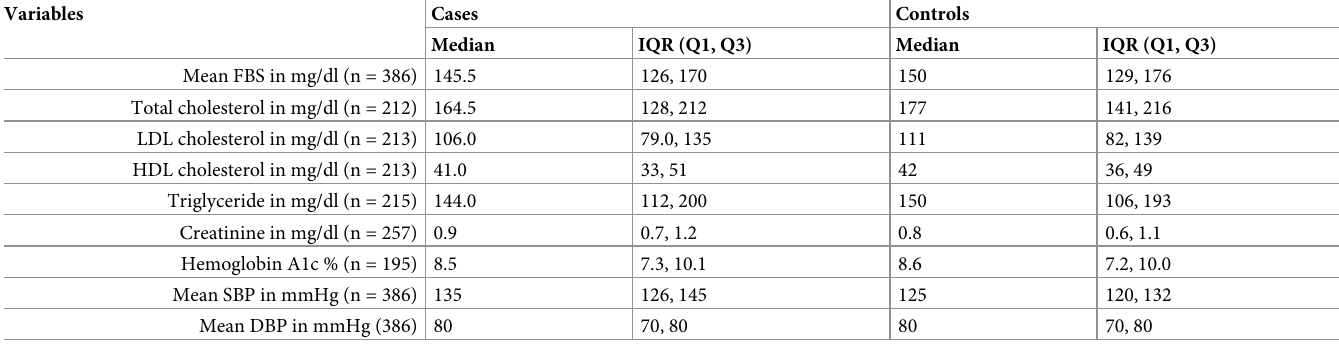
Key: FBS = Fasting blood sugar, LDL = Low density lipoprotein, HDL = High density